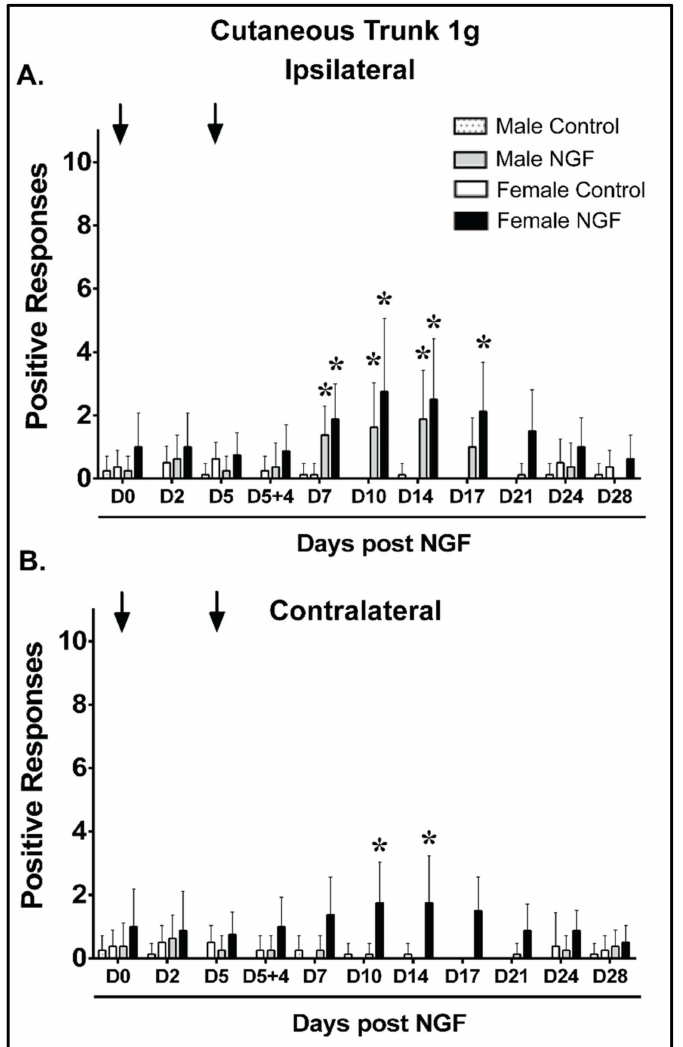
Figure 2. Females demonstrated prolonged and bilateral mechanical hypersensitivity to a 1 g cutaneous low back stimulus during persistent low back pain compared with males. ( A ) When compared to control (PBS), NGF injections (arrows, 0.8 µ M) resulted in ipsilateral low back mechanical hypersensitivity with increased mean positive responses to a cutaneous stimulus for 1 g filament from D7 to D14 in male rats and from D7 to D17 in female rats compared to baseline (D0). ( B ) NGF injections were also associated with contralateral low back mechanical hypersensitivity with increased mean positive responses to a cutaneous 1 g filament stimulus at D10 and D14 in female rats only when compared to baseline (D0). No significant changes were noted in males compared to D0. No significant differences were detected at D0 when comparing all groups ( A , B ). Data are reported as means ± SD and analyzed by two-way ANOVA with Bonferroni’s comparisons to baseline within a group or two-way ANOVA with Tukey’s multiple comparisons between groups for n = 8/group. * p < 0.01 vs. D0 prior to